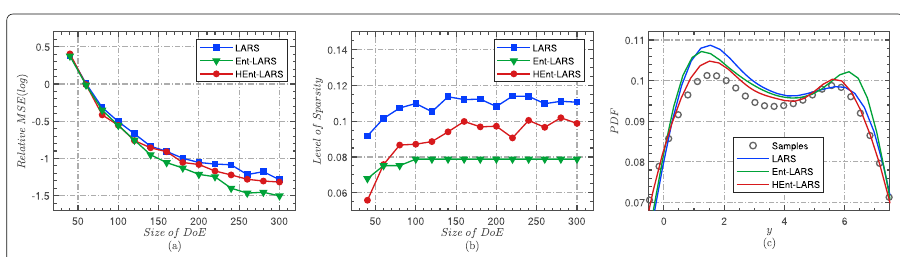
Fig. 3 Performance comparison of LARS, Ent-LARS and HEnt-LARS w.r.t. the Ishigami model. ( a ) The relationship between the relative MSE and the size of DoE; ( b ) The relationship between the sparsity level of several methods and the size of DoE; ( c ) Enlarged details of the reconstructed PDF